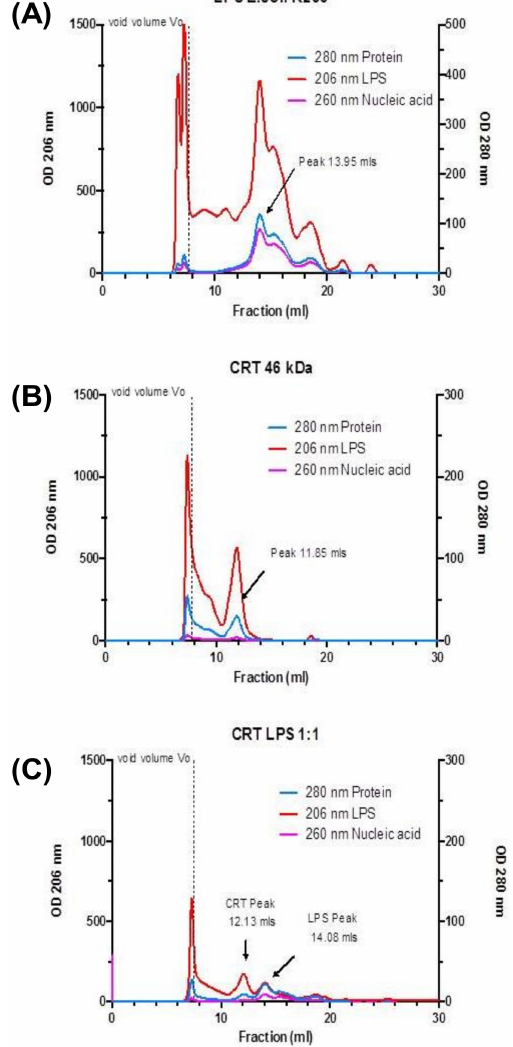
Figure 5. Size exclusion chromatography shows that CRT oligomerizes in the presence of LPS and contaminating LPS elutes with CRT. LPS ( A ), Purified recombinant calreticulin ( B ), or LPS mixed with CRT (1:1 w / w ) ( C ) and incubated at 4 ◦ C overnight were subjected to size exclusion chromatography (Superdex 200) in Tris buffered saline (TBS). LPS (red) already bound (contaminating) to CRT (middle graph) and additional LPS causes CRT (blue; lower graph) to elute in the column void volume and in multiple fractions through the internal diameter of the